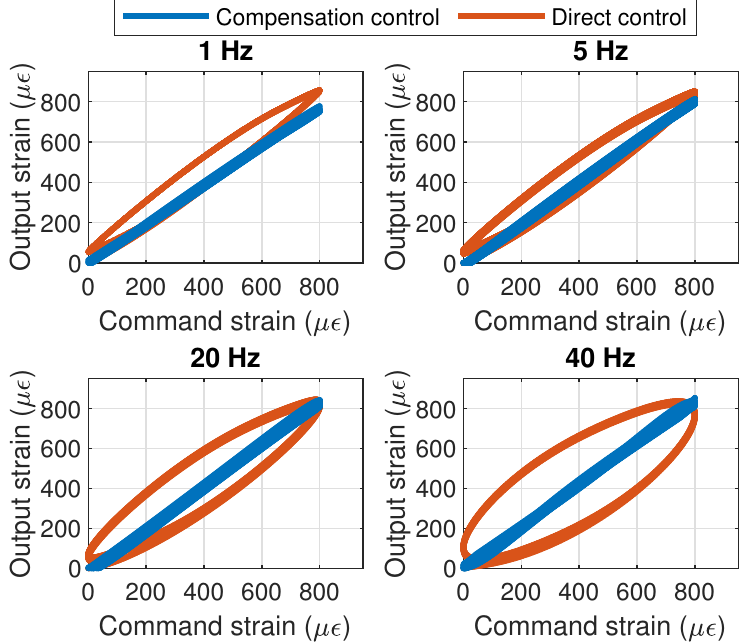
Figure 15. Control using compensation in sine